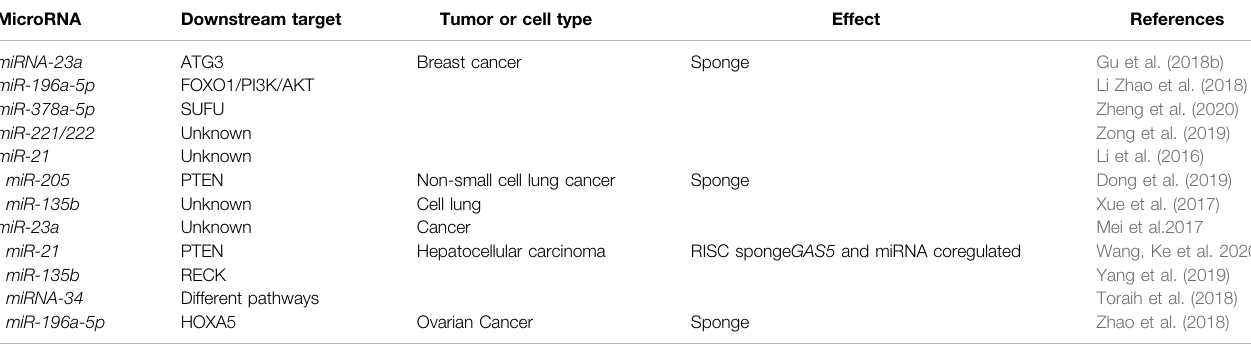
TABLE 1 | The roles of different microRNAs associated with GAS5